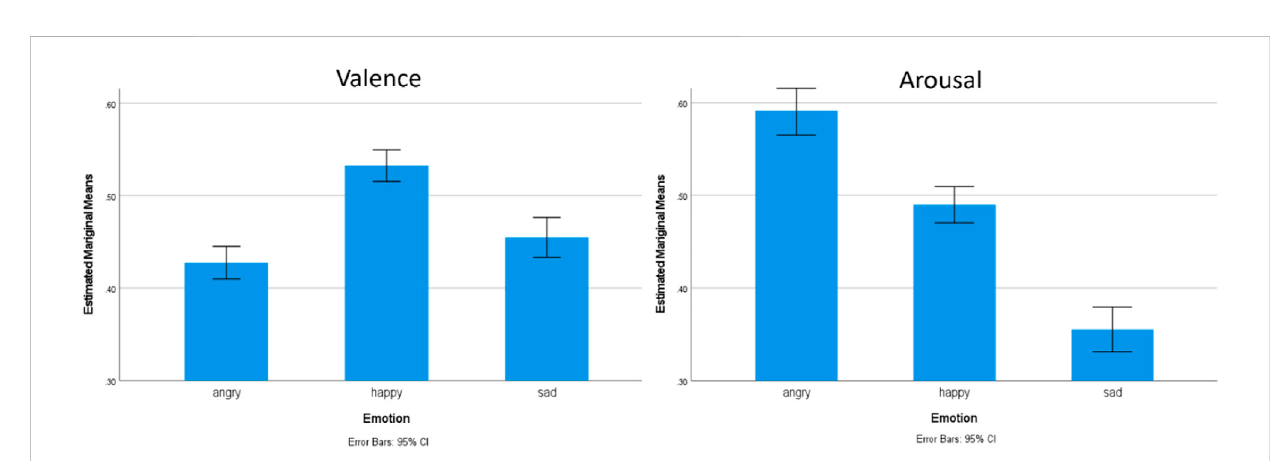
Differences in perceived valence and